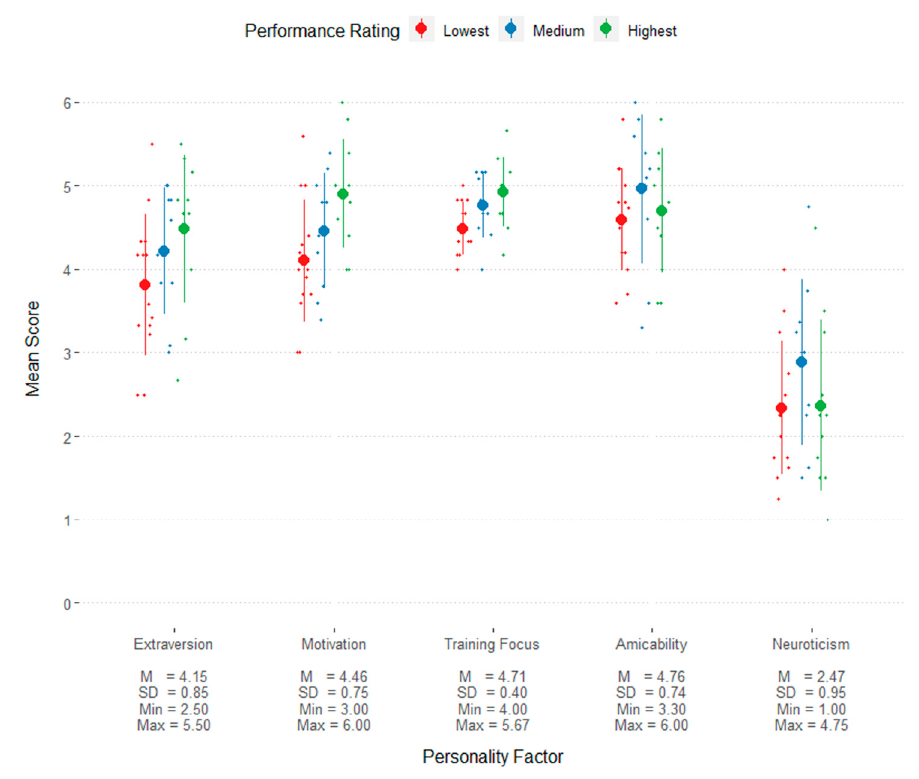
Figure 5. Scores of MCPQ-R personality factors for each group of performance rating. The circles indicate the mean and lines indicate the standard deviation. Each point is an individual dog’s score. For illustrative purposes, performance ratings groups were determined from the dogs’ overall performance rating scores allocated into three equal groups of the lowest, middle, and highest ratings. Table 5. Expected correlations between work behaviour factors and personality factors with calculated correlations and significance with Holm–Bonferroni correction. The Holm alpha is the alpha needed for significance to correct for family-wise error